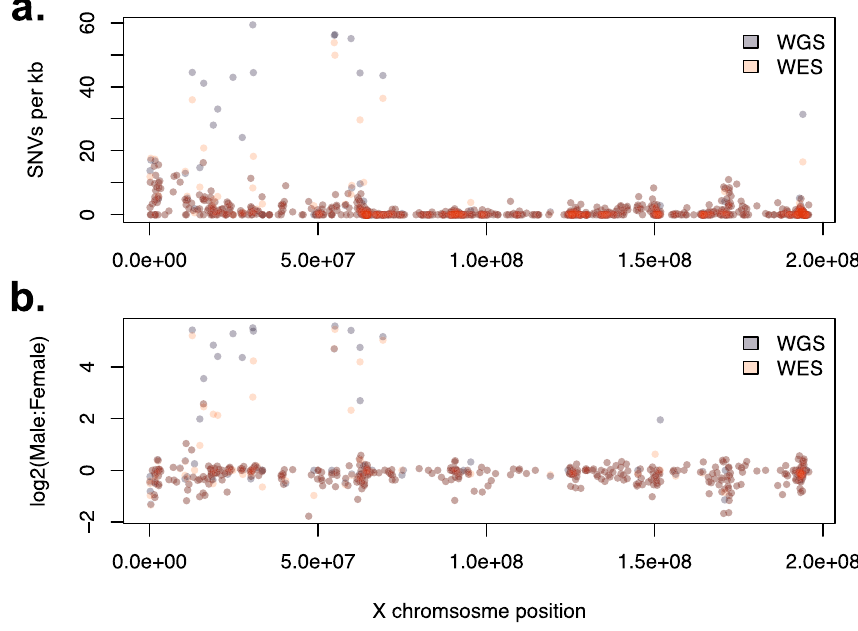
Figure 4. Distribution of SNPs per gene along chromosome X. ( a ) Total SNPs per kb of coding sequence per gene. ( b ) Sex biased variant detection along chromosome X. Bias is calculated as fold change ratio between the mean number of SNPs per individual per gene for males and females. Specifically, this was calculated for each gene as log2((mean male SNPs + 1)/(mean female SNPs + 1)). The ones were added to remove undefined results caused by dividing by the number